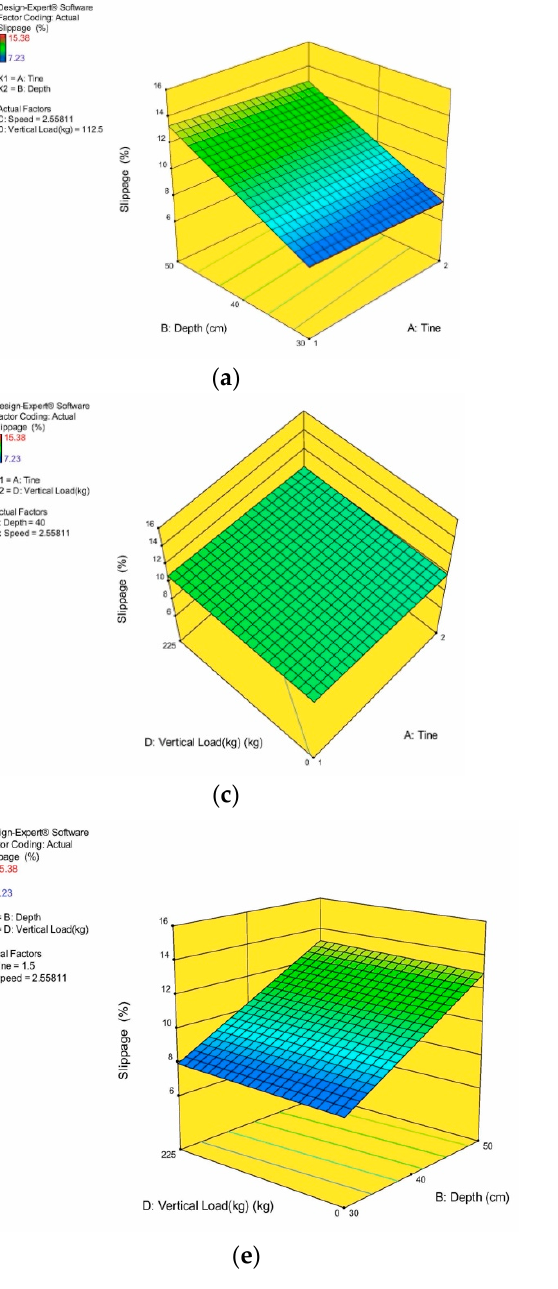
Figure 7. 3D surface curves of slippage as influenced by interactions between input parameters using the RSM approach; ( a ) tine and depth, ( b ) tine and speed, ( c ) tine and vertical load, ( d ) depth and speed, ( e ) depth and vertical load, and ( f ) speed and vertical load.